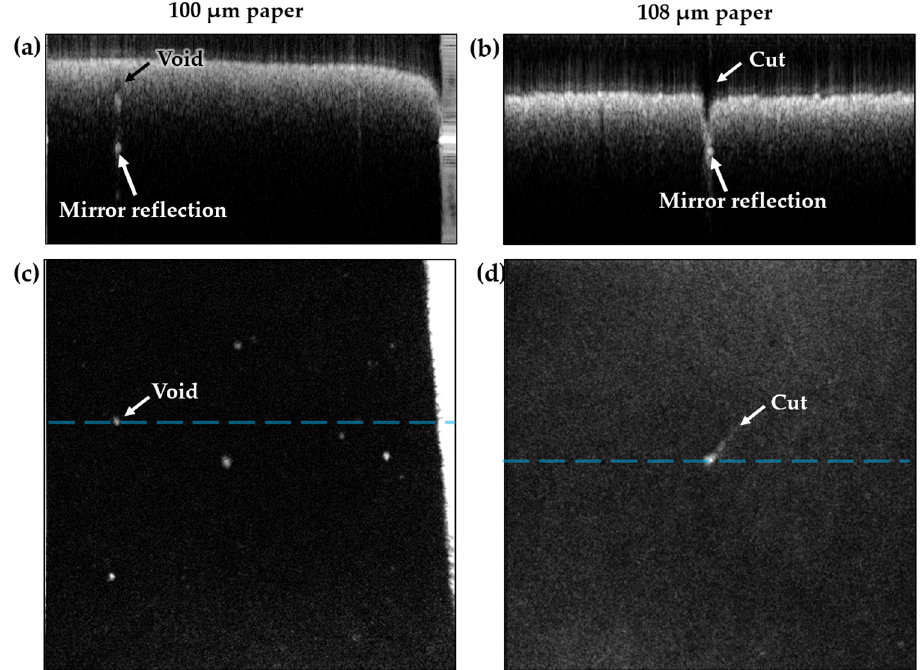
Figure 8. Paper defect detection. ( a ) Average of five B-scans of a 100- μ m paper sample with internal voids resulting in a strong reflection from the bottom of the void and from the mirror. ( b ) Average of five B-scans of a cut in a 108- μ m paper sample, revealing the mirror below. ( c , d ) Top-view volume projections of the subsurface reflections due to voids and the cut, respectively.